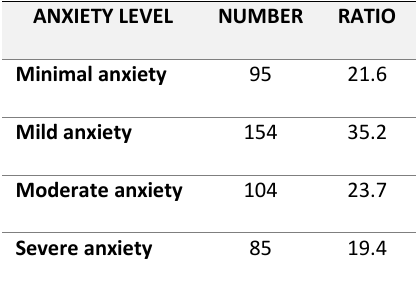
Table 2. Frequency distribution of study participants with different anxiety levels